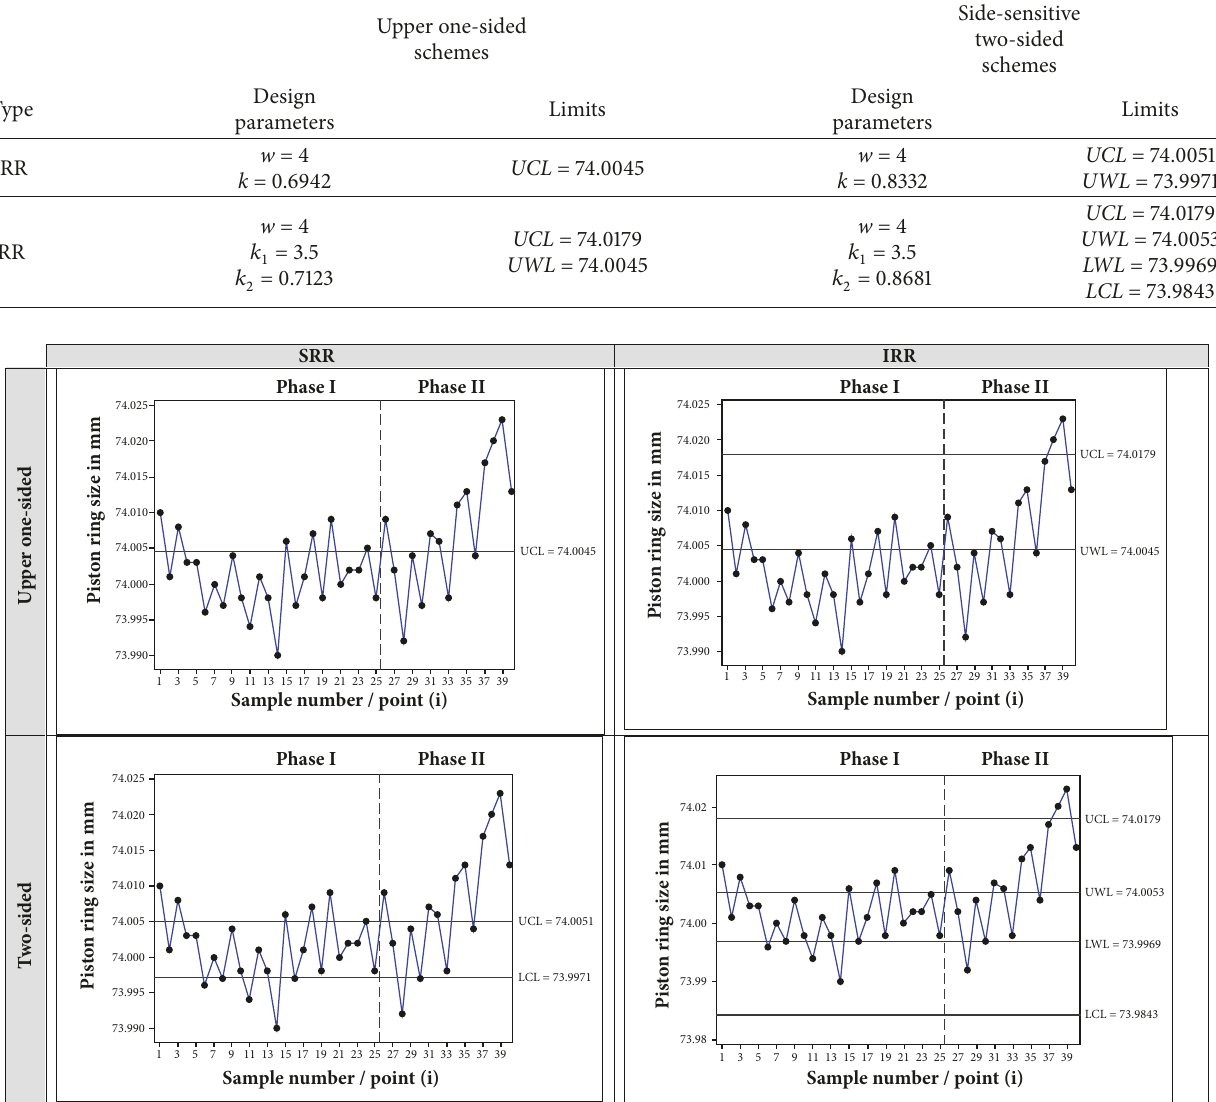
Figure 5: Upper one-sided and two-sided SRR and IRR schemes to monitor the mean of piston ring